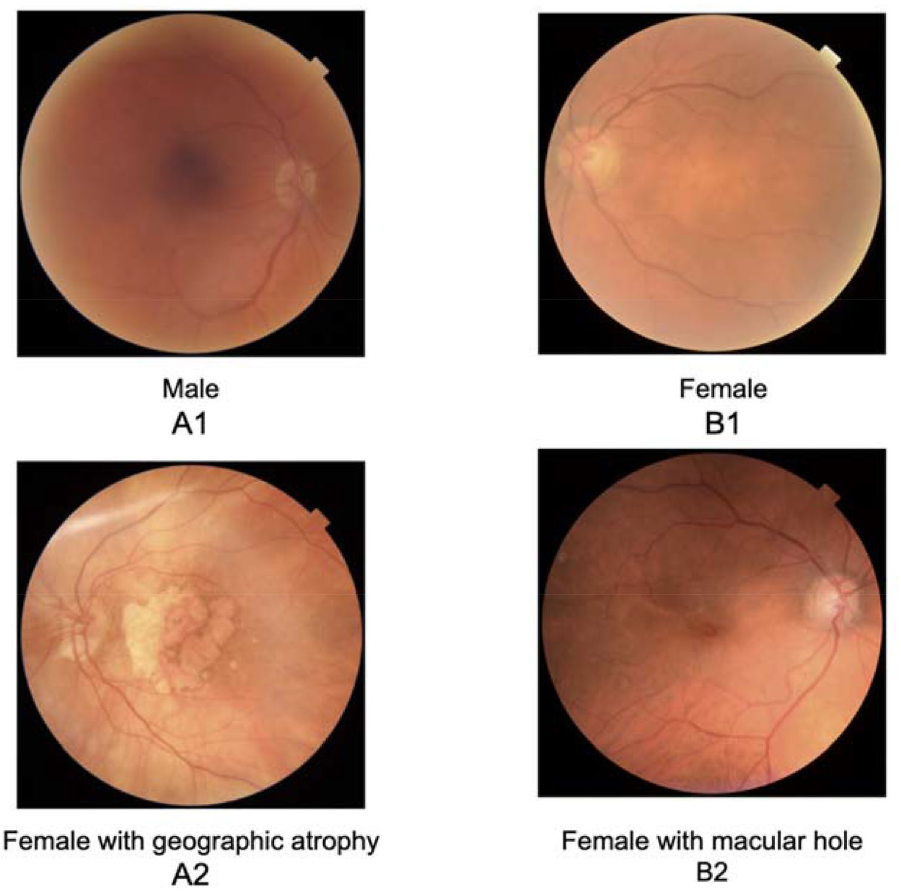
Figure 3. Representative Fundus Photos. Correct ( A ) and incorrect ( B ) cases without (1) and with (2) foveal